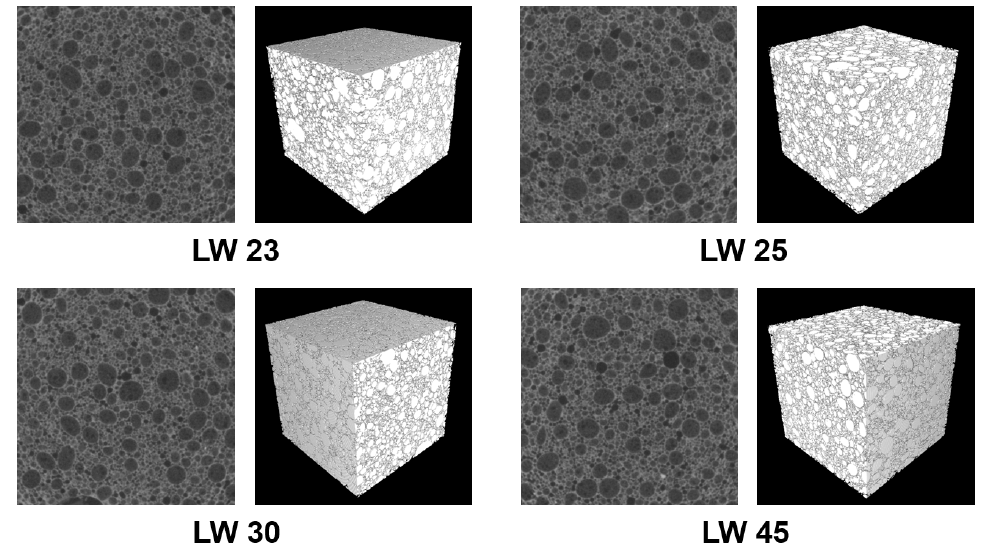
Figure 8. Sample CT images and 3D LWA images of each sample (note: the left figure is the original X-ray CT image, and the right figure is the 3D